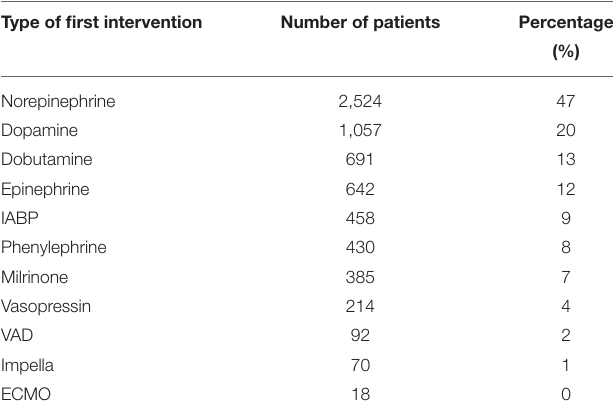
TABLE 2 | The distribution of the type of first intervention received by patients with diagnosis of CS.